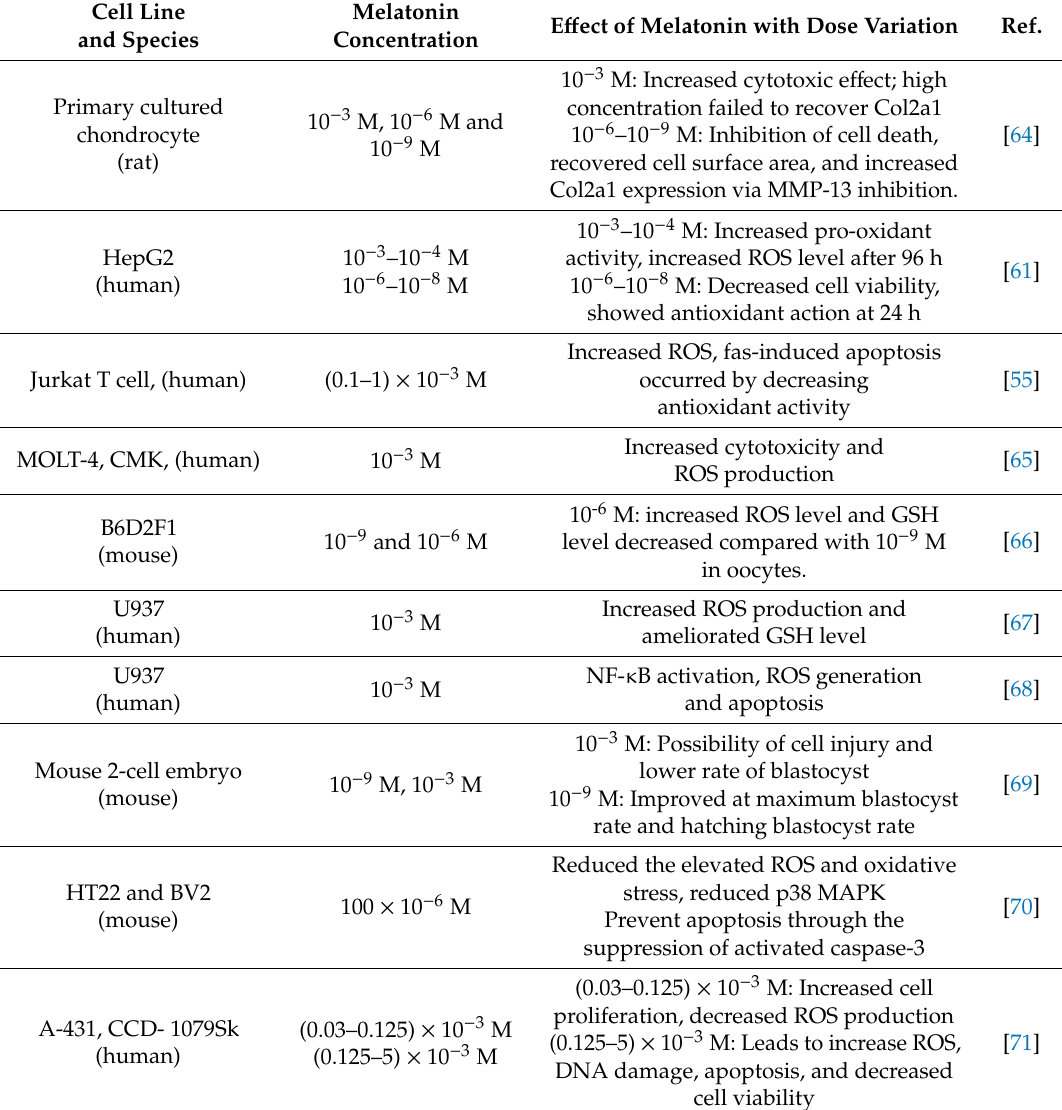
Table 1. E ff ects of various concentrations of melatonin (in